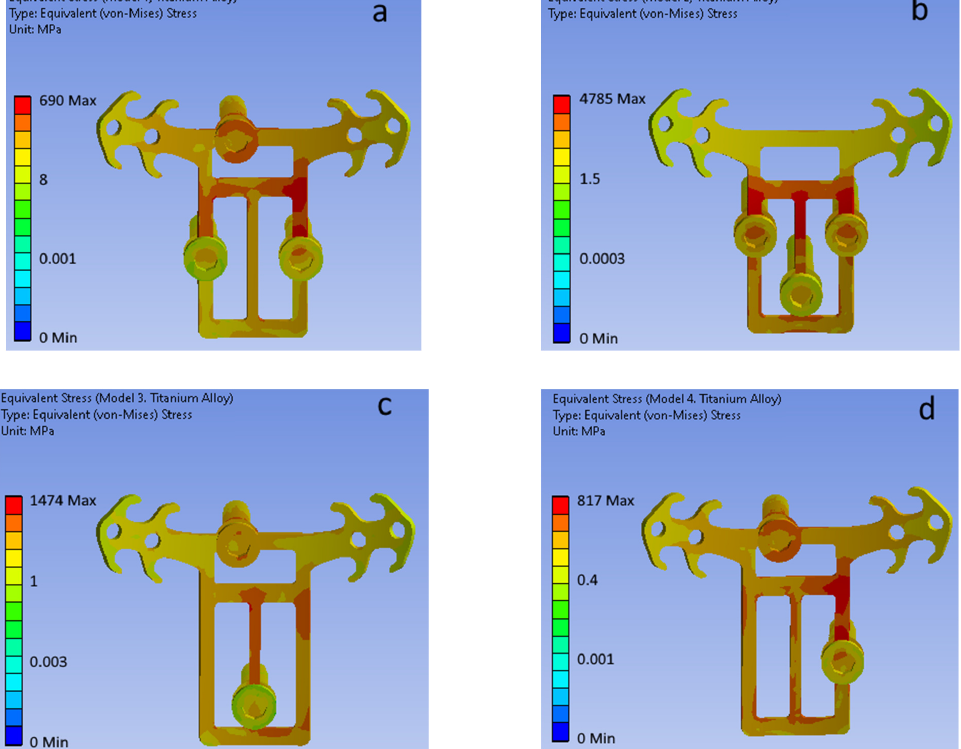
Figure 6. Total displacement fields for ( a )–( d ) mini-implant configurations (POD material—tita- nium alloy). ( a ) Model 1. ( b ) Model 2. ( c ) Model 3. ( d ) Model 4. Figure 7 shows equivalent (von Mises) stress fields for each of the considered mini- implant configurations (POD is made of titanium alloy).